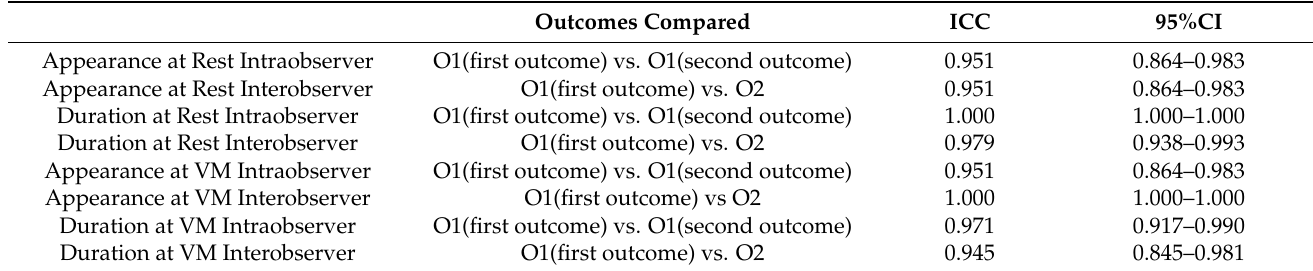
Table 4. Intraobserver and Interobserver Variability of Characteristics of